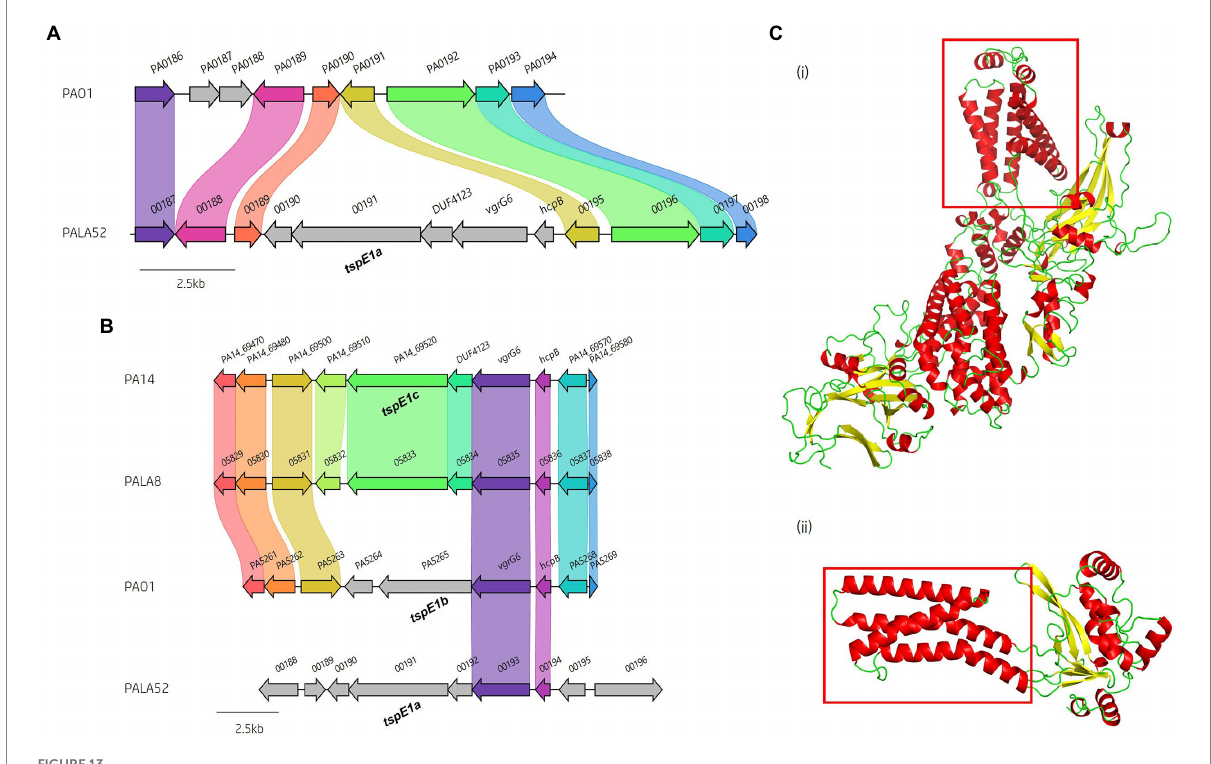
FIGURE 13 Genes encoding three different ( tsep1a/b/c ) putative T6SS secreted pyocin effectors are present in vgrG6 islands from different isolates. (A) Visualisation showing the genomic location of the vgrG6 island in PALA52 compared to PAO1. The vgrG6 island genetic location in PAO1 and most strains is shown in panel B. (B) Comparative visualisation of vgrG6 islands within clinical isolates to PAO1 and PA14 highlights the high conservation of hcpB and vgrG6 but the strain variation of downstream genes. The vgrG6 island from PAO1 encodes a putative pyocin effector tspE1b (PA5265). Isolate PALA8 is used as a representative for the possession of PA14 vgrG6 island and EI module tspE1c / tspI1c (05833). The vgrG6 island from PALA52 encodes a third putative pyocin-type effector tspE1a (00191). (C) Alphafold (Jumper et al., 2021; Varadi et al., 2022) prediction of (i) TspE1b (PA5265) and (ii) TspI1b (PA5264) from P. aeruginosa strain PAO1 visualised using PyMOL (The PyMOL Molecular Graphics System, Version 2.5.4, Schrödinger, LLC). The red box in (i) indicates the location of the pore-forming α -helical bundle, while the red box in (ii) indicates the four transmembrane helices of the putative